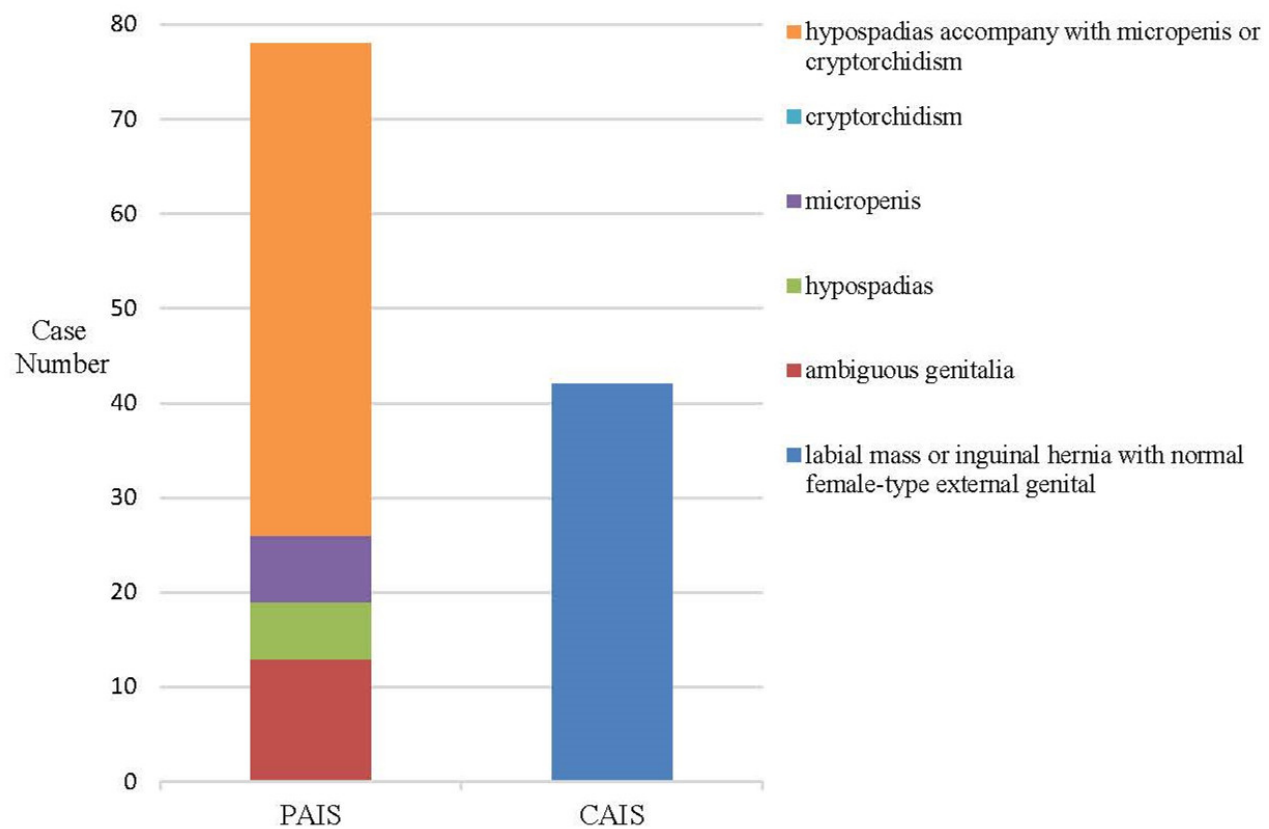
Figure 1. Phenotype of 118 Chinese children with AIS.